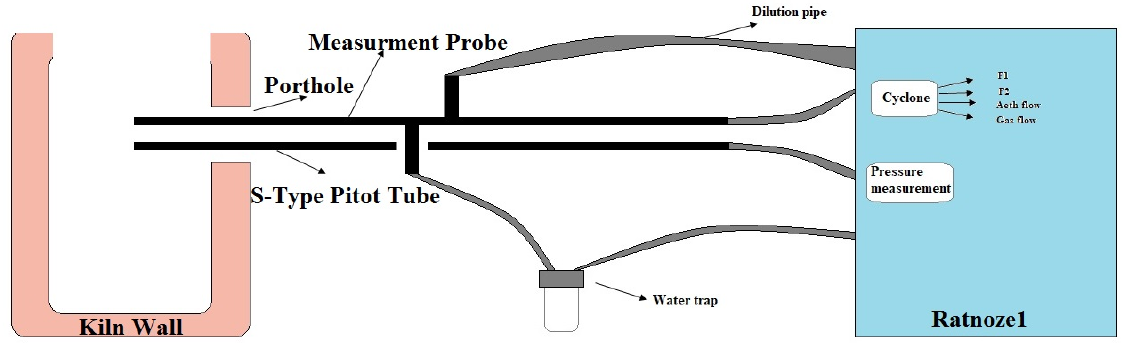
Figure 3. Block diagram of the sampling procedure.